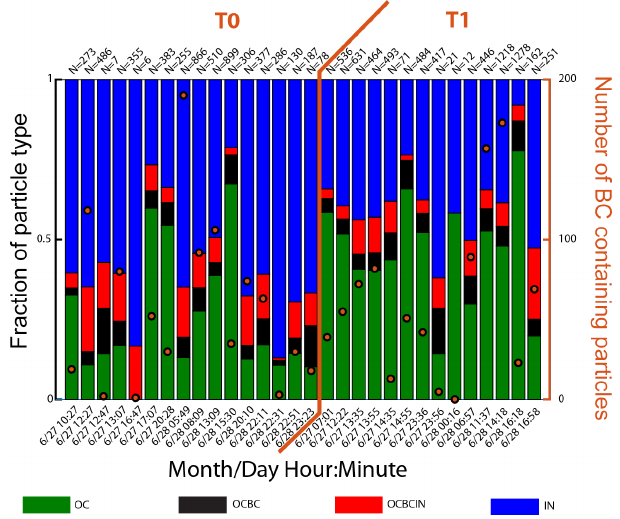
Figure 3. Summary of all particles analyzed from the CARES STXM data set. Green bars represent particles only containing the OC rich phase, black bars indicate particles containing BC and OC, red indicates the fraction of particles containing OC, BC, and IN, and blue bars indicate the fraction of particles containing an inor- ganic dominant phase (IN). Orange dots indicate the total number of BC particles analyzed from a particular sample. The total number ( N ) of particles analyzed in each sample is indicated on the top of the